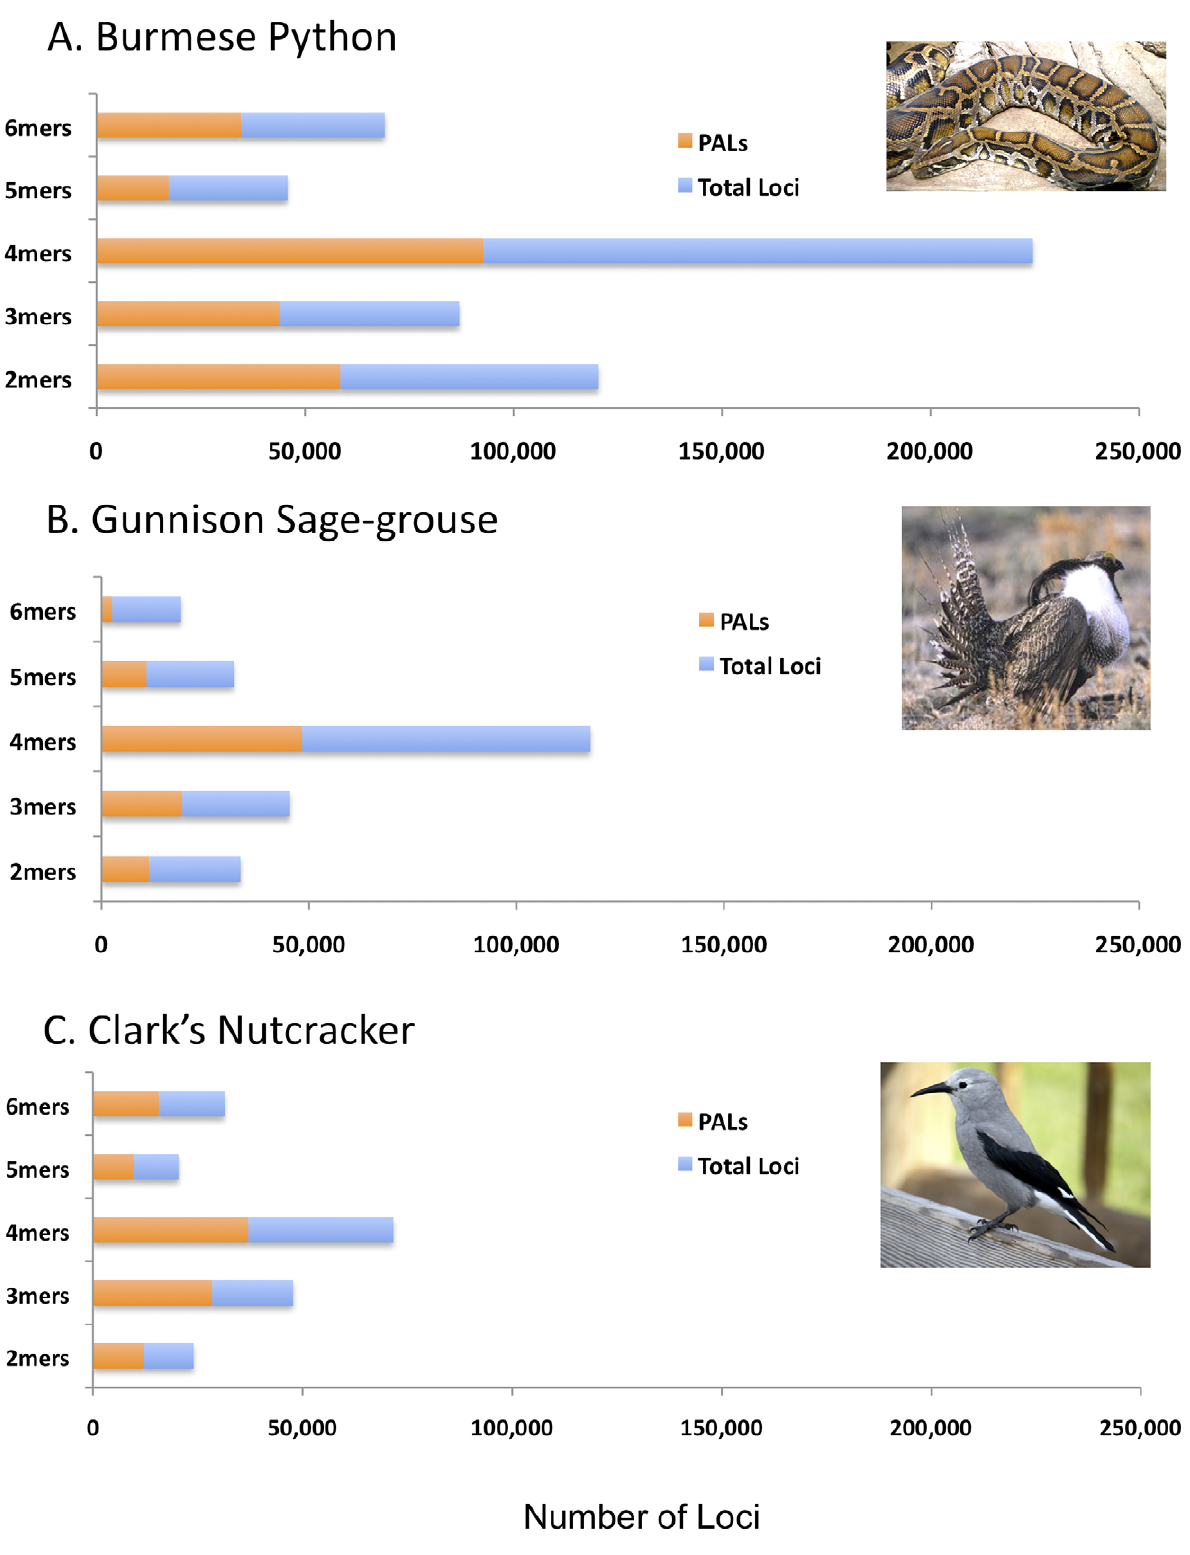
Figure 2. Comparison of identification of microsatellite loci and ‘potentially amplifiable microsatellite loci’ (PAL) among bird and python samples. Analysis based on using five million Illumina long (114–116 bp) paired-end reads from a shotgun genomic library for each species.